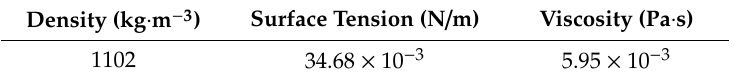
Table 3. Parameters used in lumped element modeling. FEM—finite element modeling.